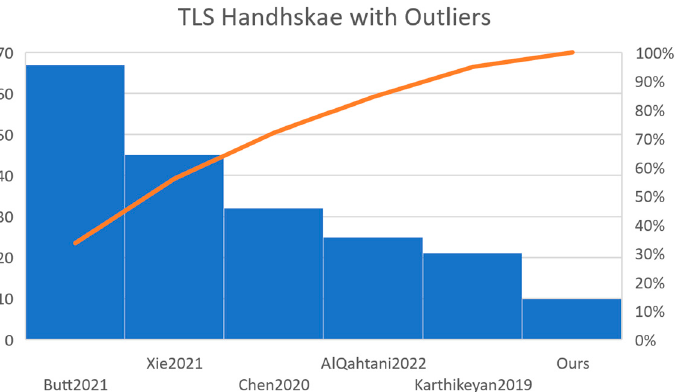
Figure 3. Time and energy measured for 32 bytes of random data that are relative within the implementation of the references mentioned. The median of the values, rounded to the nearest percent, and n = 100 are taken into consideration. References: AlQahtani2022 [25], Karthikeyan2019 [28], Chen2020 [29], Xie2021 [30], Butt2021 [31].